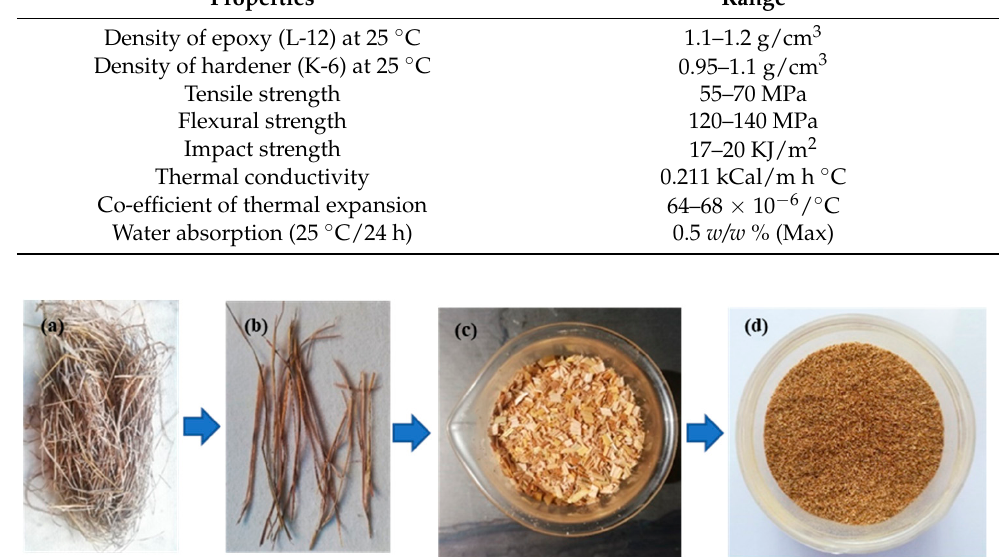
Figure 1. Preparation of RS particles ( a ) Bale, ( b ) Segregation, ( c ) Particles and ( d ) Fine RS particles.